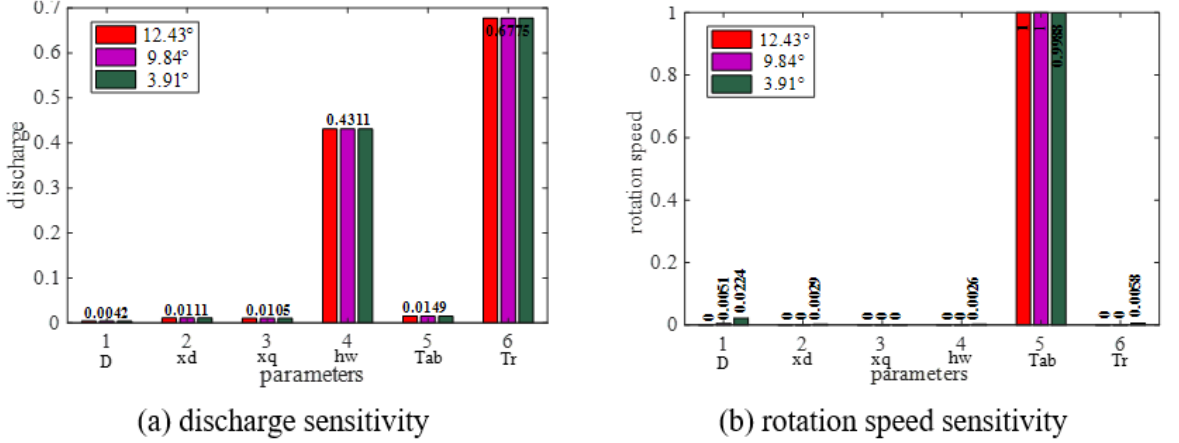
Figure 6. Parameter sensitivity under three typical GVOs (12.43°, 9.84°, and 3.91°).